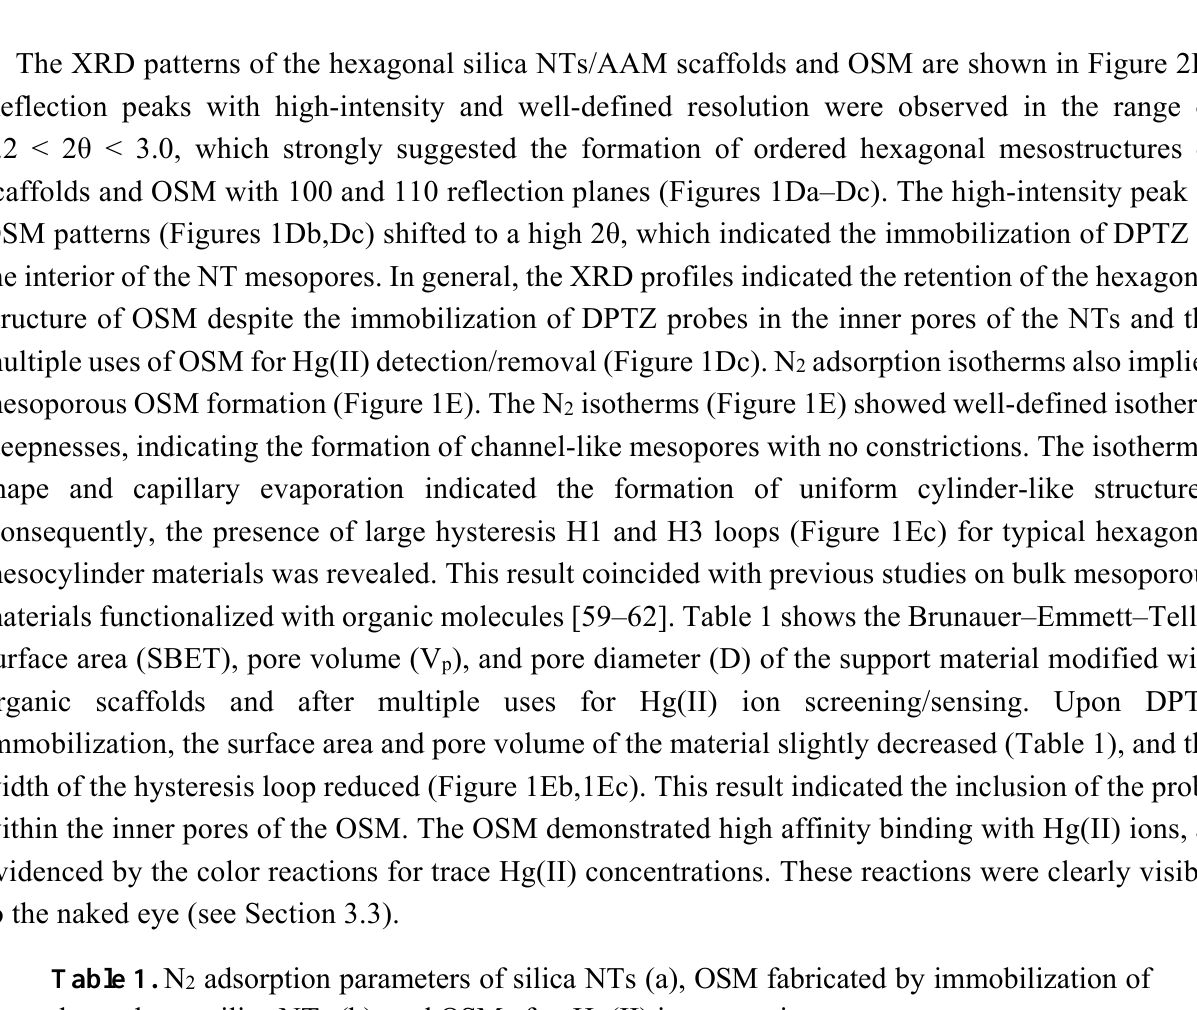
Table 1. N 2 adsorption parameters of silica NTs (a), OSM fabricated by immobilization